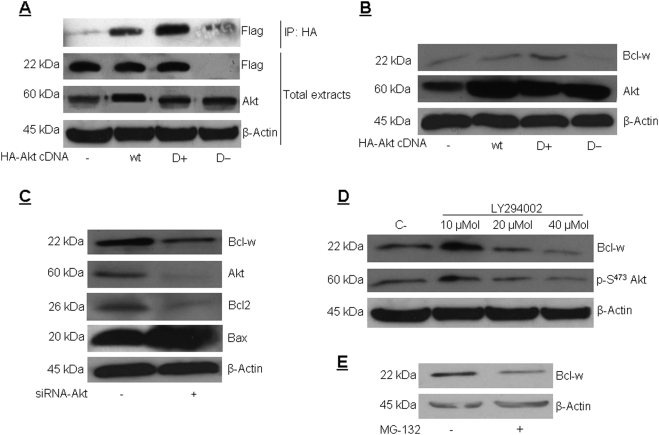
Akt activity regulates Bcl-w expression.(A) HeLa cells were transfected with 2 µg of HA-Akt wt, Akt D+, or HA-Akt D− cDNA and 2 µg Flag-Bcl-w for 48 hrs. Protein extracts were immunoprecipitated with an anti-HA monoclonal antibody. Immunoprecipitates were resolved on 12% SDS-PAGE and transferred to Hybond-C nitrocellulose. Membranes were incubated with anti-Flag antibody (0.2 µg/ml). 50 µg of total sample extracts were also analyzed by western blot using the indicated antibodies. Loading control was obtained using anti-β actin antibody. (B) HeLa cells were transfected with 4 µg of HA-Akt wt, HA-Akt D+, or HA-Akt D− cDNA for 48 hrs. Protein extracts were blotted with anti-Bcl-w antibody in order to detect endogenous levels of Bcl-w. Loading control was obtained with anti-β actin antibody. (C) Cells were transfected with 100 nM of siAkt-RNA for 48 hrs. Cellular proteins were solubilized and analyzed by western blot using the indicated antibodies. (D) HeLa cells were treated with 10, 20 or 40 µM of LY294002 for 24 hrs. Protein extracts were analyzed by western blot using the indicated antibodies. Loading control was obtained using anti-β actin antibody. (E) Bcl-w HeLa cells were treated with 10 µM of MG-132 for 8 hrs. 40 µg of protein extracts were analyzed by western blot with anti-Bcl-w antibodies. Loading control was obtained using anti-β actin antibody.